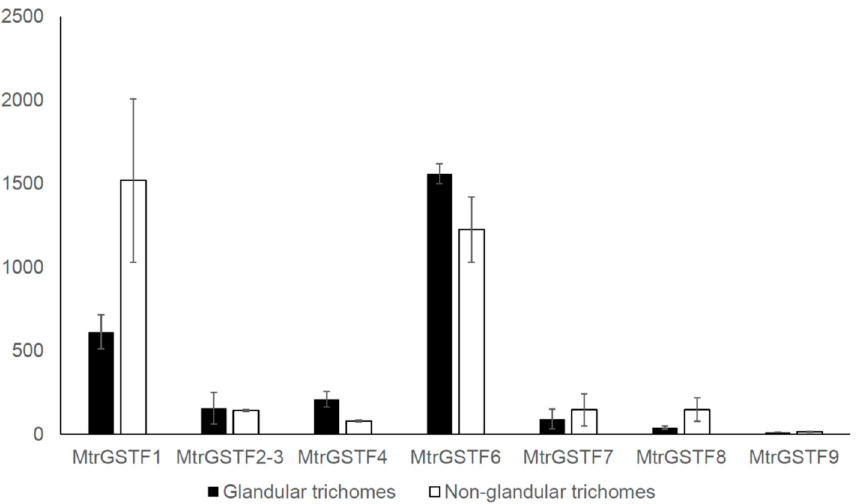
Figure 8. MtrGSTFs expression in glandular (black bars) and non-glandular trichomes (white bars). A redirection of metabolic flux from anthocyanin to flavonol biosynthesis has been demonstrated in the Arabidopsis tt19 mutant background [15]. It is noteworthy that the metabolic shift is not associated with a reduced expression of anthocyanin biosynthetic genes which are instead expressed at higher levels in tt19 compared to wt plants. A similar picture was observed in MtrGSTF7 mutant lines, in which the dramatic reduction in the MtrGSTF7 transcripts levels was paralleled neither from that of early ( C4H , 4CL , CHS , CHI and F3 ′ H ) nor from that of late ( DFR , ANS and ANR ) key genes of the phenylpropanoid